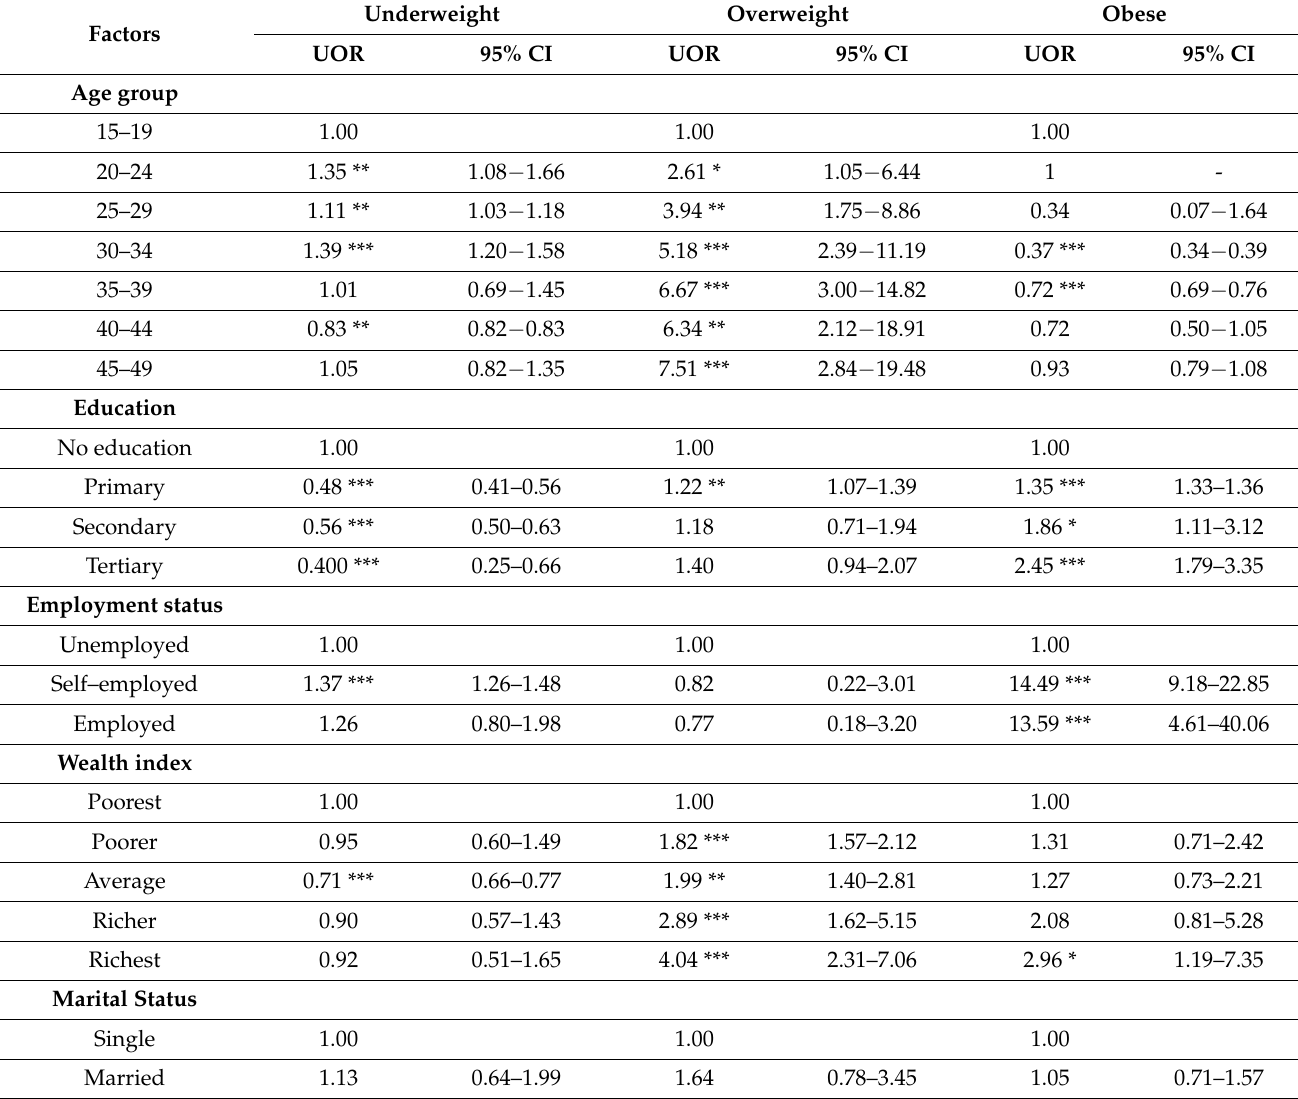
Table 5. Multi-level analysis showing the predictors of body weight among women of childbearing age and factors by urban–rural variation in